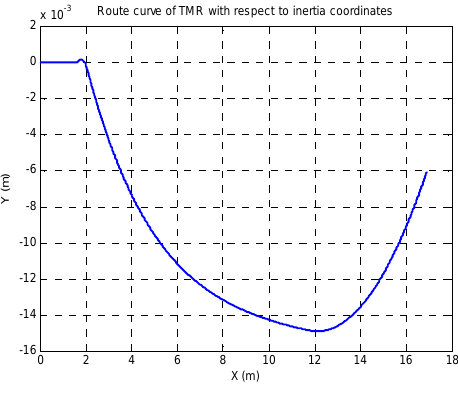
Fig.15. Results of path for K=10